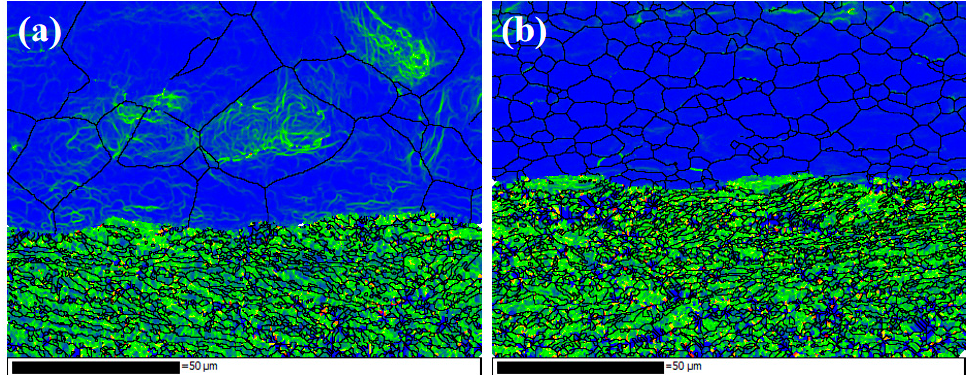
Figure 22. Kernel average misorientation (KAM) maps. ( a ) Specimens B3; ( b ) specimen C3.